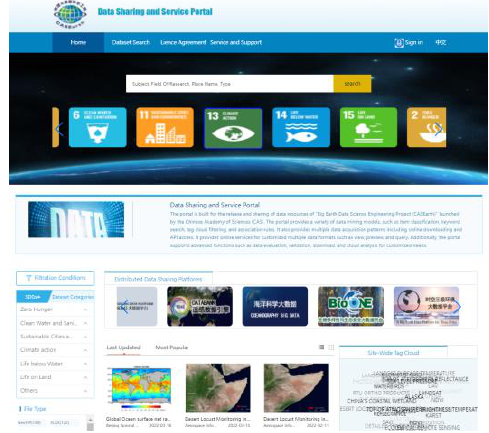
Figure 2 . Data Sharing and Service Portal by